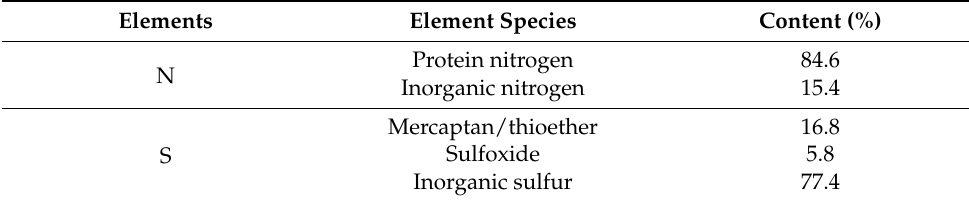
Table 3. N and S distributions over different N and S species in the AMR sample.